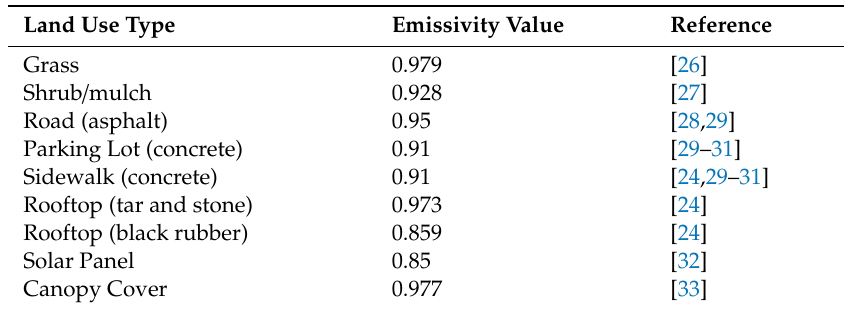
Table 4. Emissivity values for each surface type.